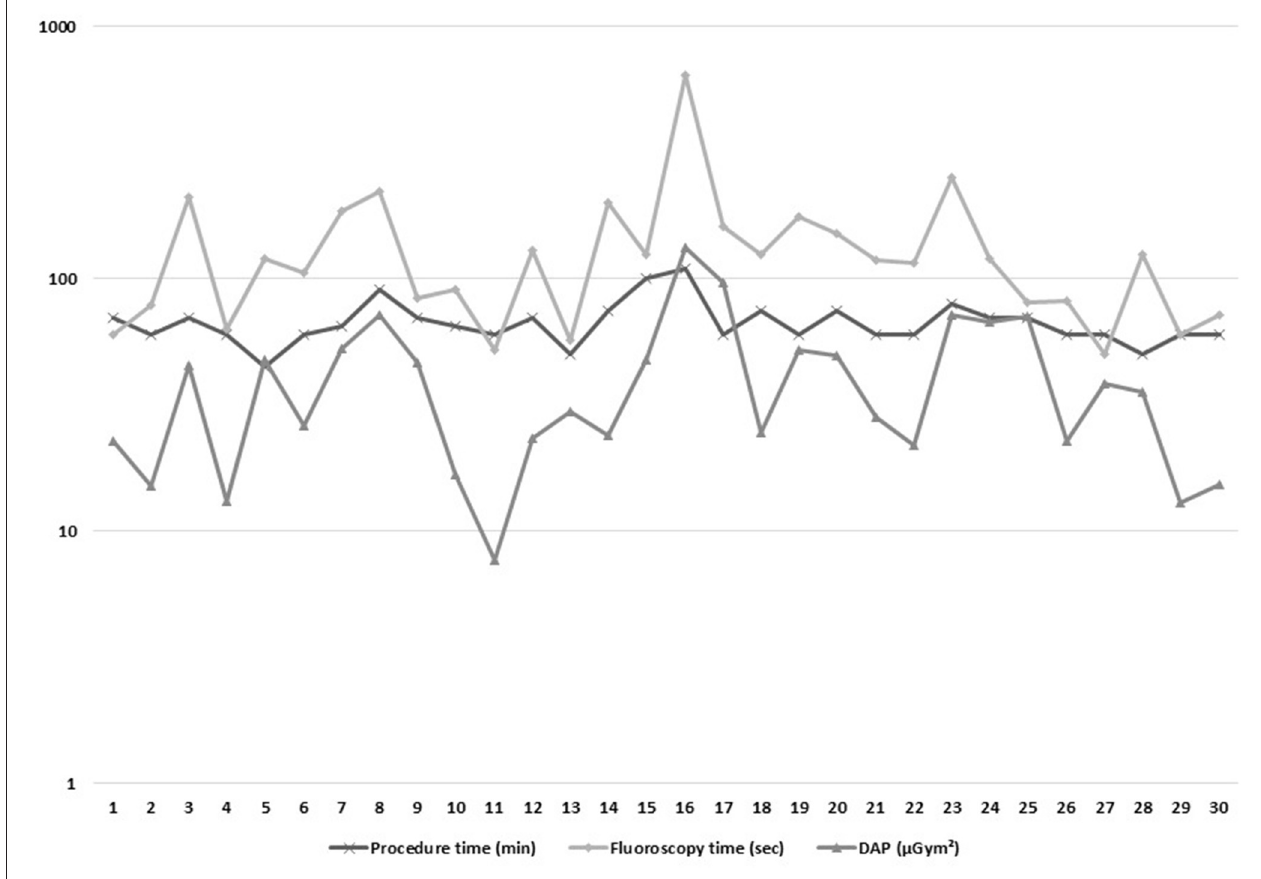
FIGURE 2 | Characteristics of the 30 ablations using EMS/FIS with regard to procedure time (min), fluoroscopy time (sec), and dose-are-product (DAP, µ Gym ² ).